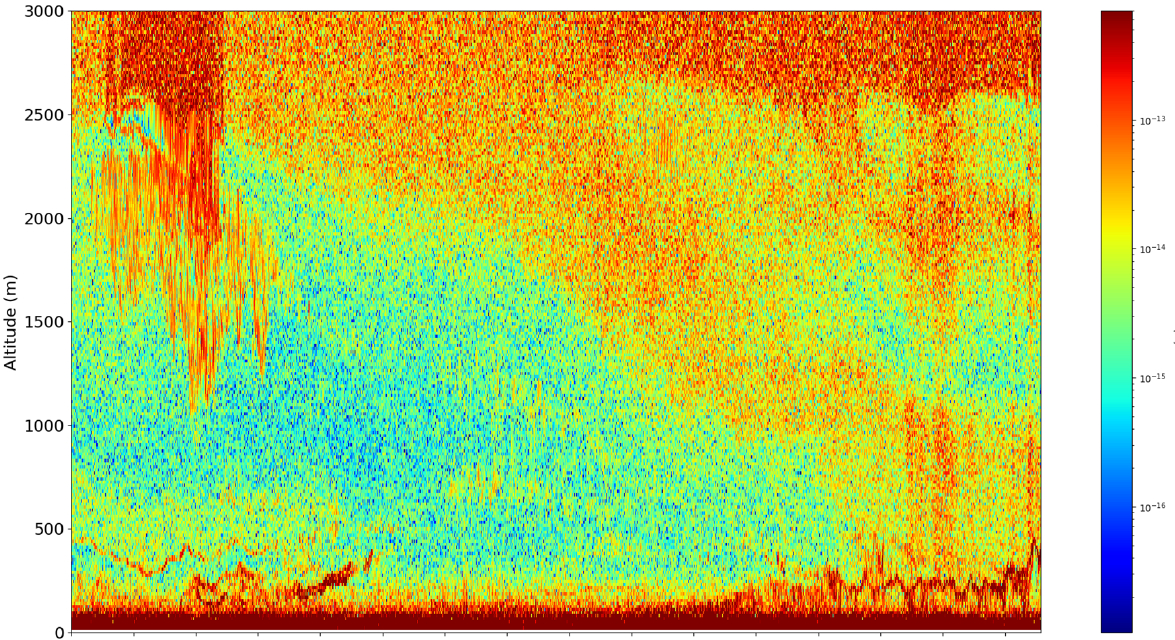
i, Romania, 22 December 2021. ,